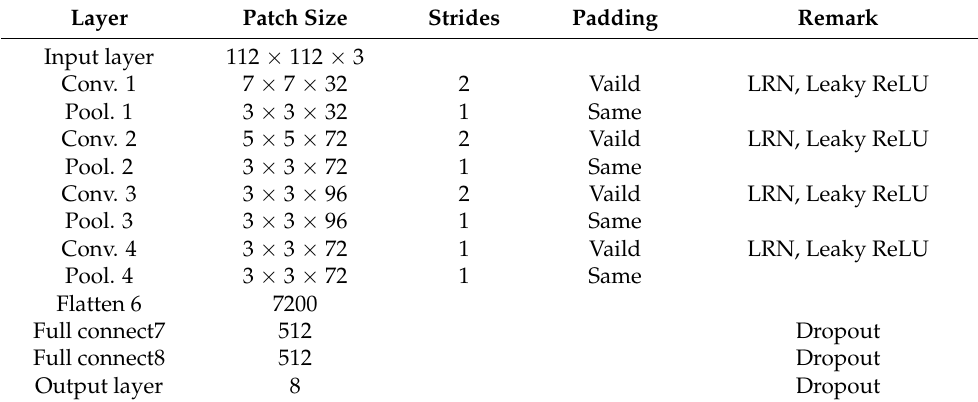
Table 4. Configuration of the new network-final